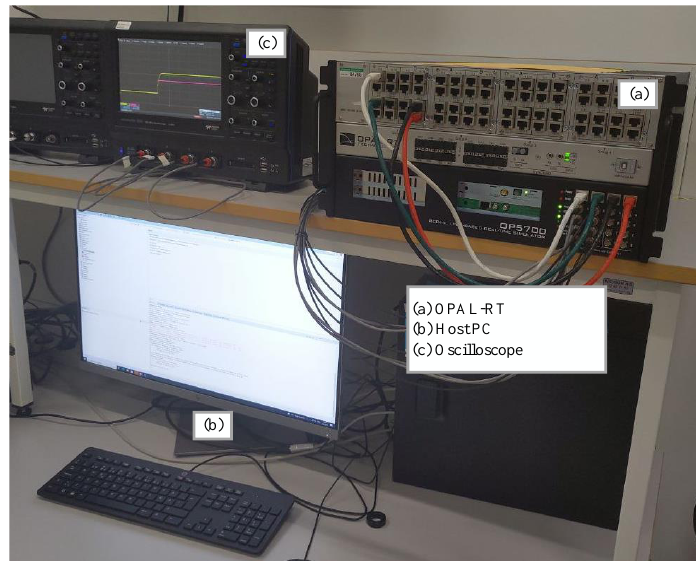
Figure 14. Real-time setup.